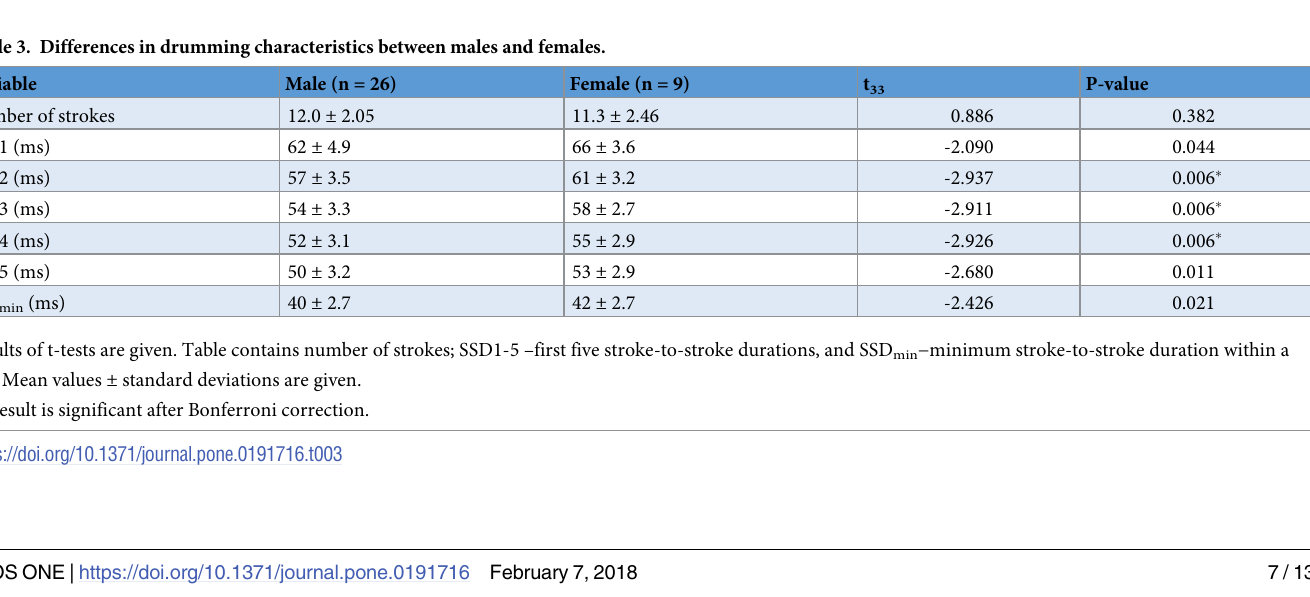
= 1.804; SSD1: t = -1.846; 19 19